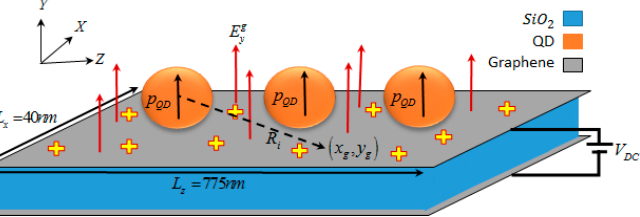
Figure 3. Illustration of the electric field emitted from the charged sheet of graphene nanoribbon and polarization of QDs.